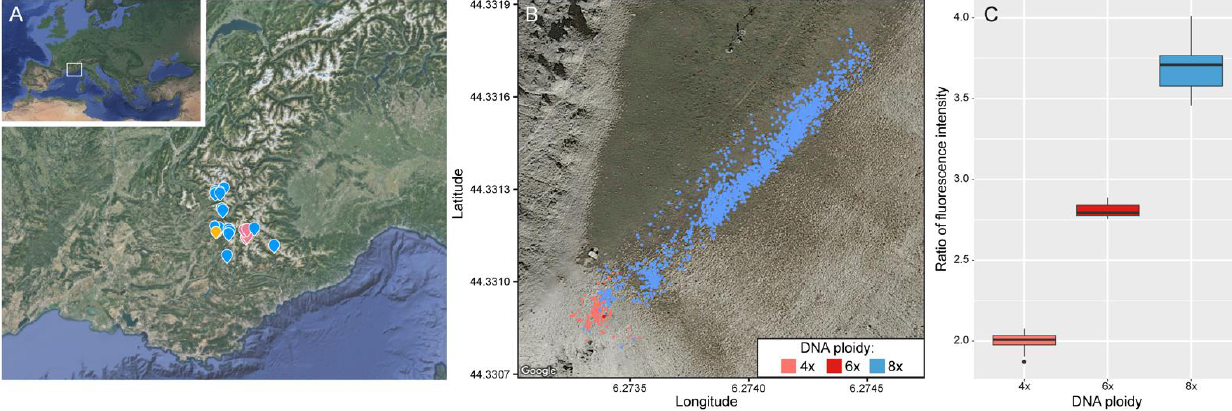
Figure 2. ( A ) Geographical distribution of the population of Senecio doronicum from Tête Grosse ( ). Additional sites sampled in the Southwestern French Alps are also indicated in the map and the cytotypes recovered indicated (4x = , 8x = ). ( B ) Distribution of individuals in the population of Tête Grosse, colored according to their cytotype. ( C ) Boxplots depicting the DNA ploidy levels assigned on the basis of relative fluorescence ratios of nuclei. Data Maps from Google Earth: Google Landsat/Copernicus Data SIO, NOAA, U.S. Navy, NGA, GEBCO. GeoBasis-DE/BKG (©2009) Inst. Geogr. Nacional.